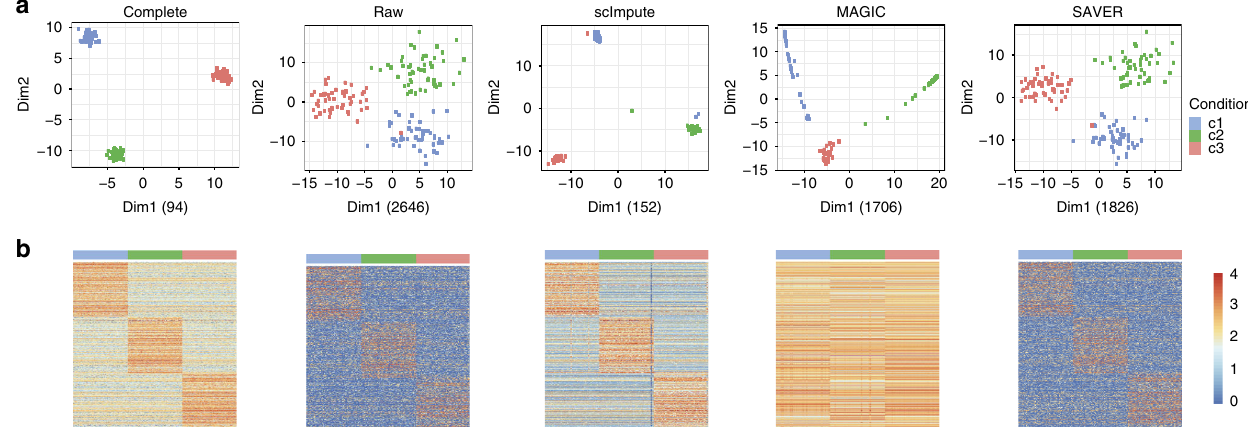
Fig. 4 scImpute corrects dropout values and helps de fi ne cellular identity in the simulated data. a The fi rst two PCs calculated from the complete data, the raw data, and the imputed data by scImpute, MAGIC, and SAVER. Numbers in the parentheses are the within-cluster sum of squares calculated based on the fi rst two PCs. The within-cluster sum of squares is de fi ned as the fi rst two PCs of cell j in cell type c k . b The expression pro fi les of the 810 true DE genes in the complete, raw, and imputed